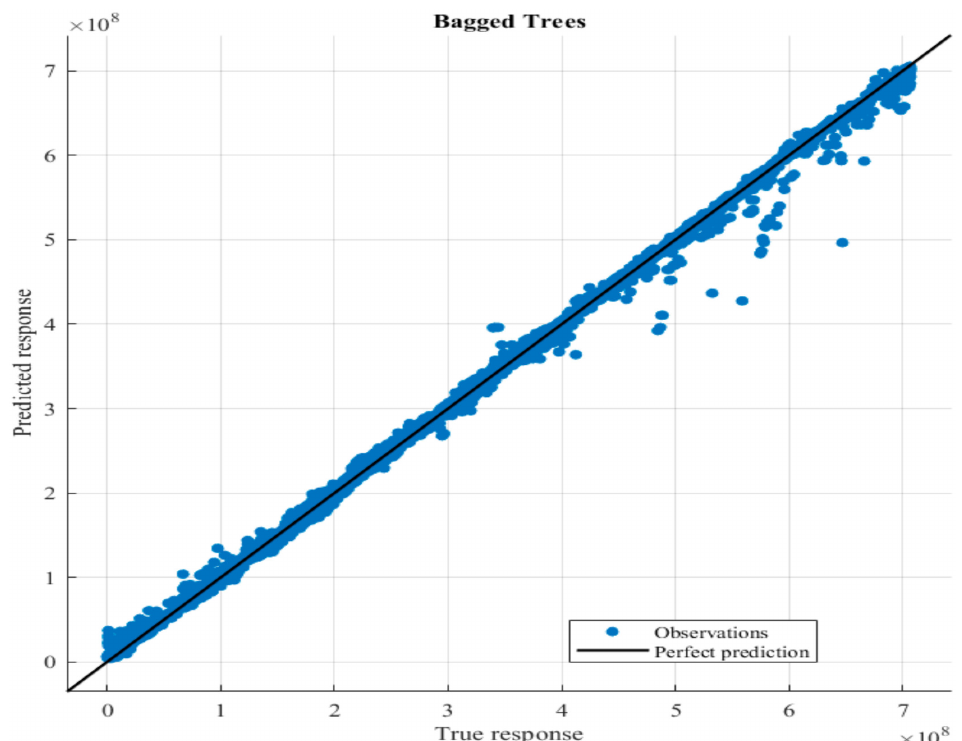
Figure 18. Bagged Trees Prediction vs. Actual